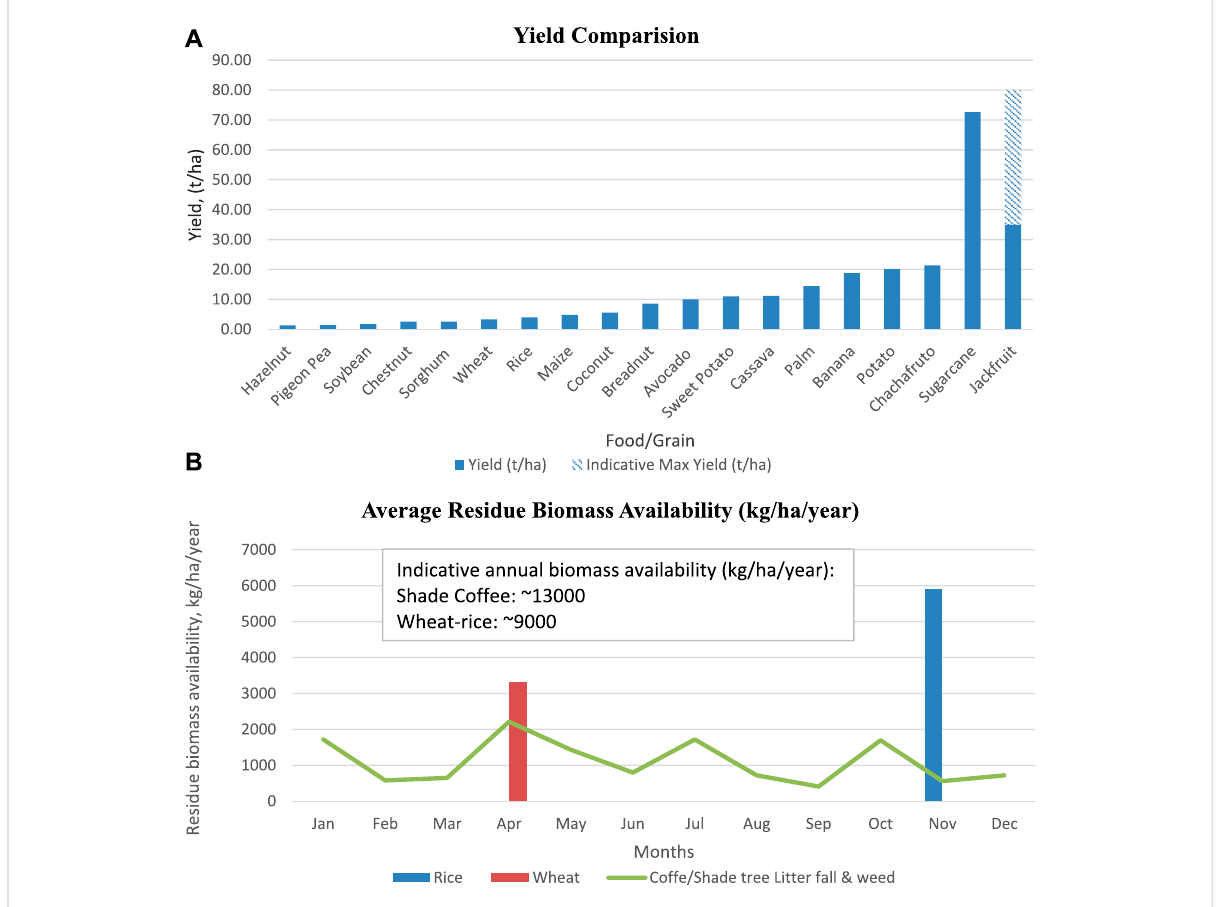
FIGURE 4 (A) .Comparativeyieldsofcommonlygrown highyielding food/grain species. Note: The yieldof jackfruitper hectare inmanyplaces isreported to be upto 80 tonnes (Balamaze et al., 2019). The shaded sections of the bars show the indicative yield ranges. (B) . Indicative values for residue biomass yield from rice, wheat (when rice and wheat are grown in consecutive seasons in the same fi eld) and shaded coffee (Evizal et al.,